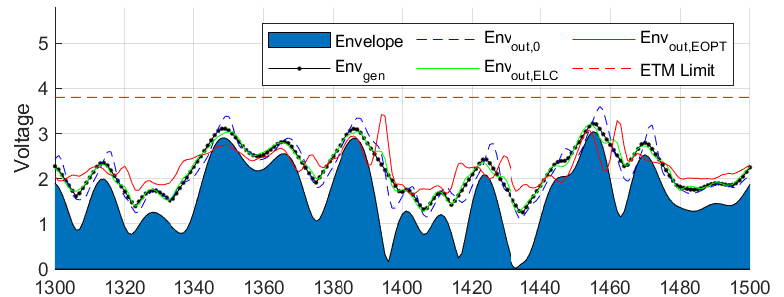
Figure 12. Time domain plots of different supply envelopes without and with different lineariza- tion